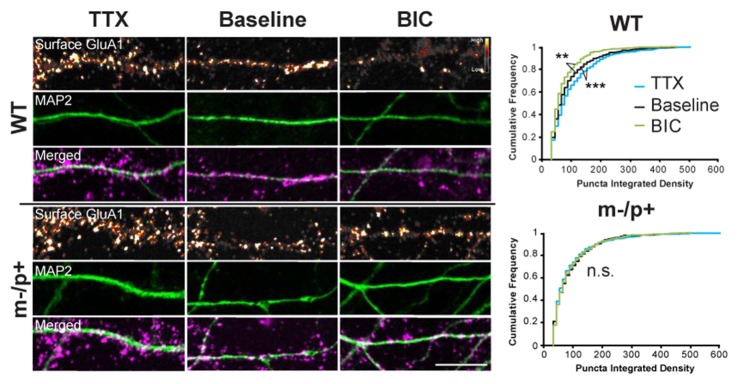
Homeostatic scaling of AMPA receptors is disrupted in Ube3am−/p+ neurons. Cultured hippocampal Ube3am−/p+ and WT neurons at DIV19–21 were treated with either TTX or BIC for 24 h to induce homeostatic scaling. Neurons were live-labeled for surface GluA1 (n = 15 neurons/group, two dendrites/neuron). BIC and TTX induced scaling of GluA1 in WT neurons, as demonstrated by a decrease or increase, respectively, in the cumulative frequency of GluA1 puncta integrated density. BIC and TTX-induced scaling was absent, however, in Ube3am−/p+ neurons. Surface GluA1: smart LUT; MAP2: green; Merged: GluA1 magenta, MAP2 green. Scale bar = 10 μm. **P < 0.01, ***P < 0.001.